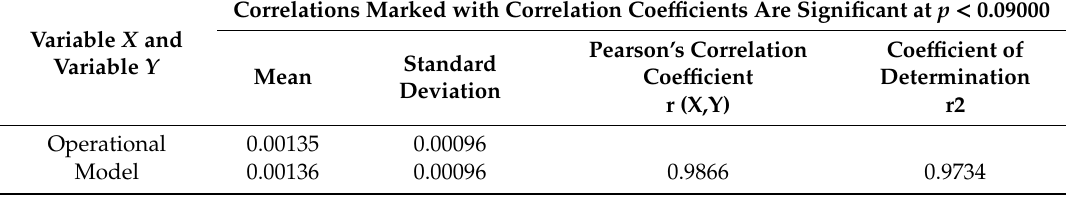
Variable X and Table 4. Results of correlation analysis for the group of tested steels in light soil.